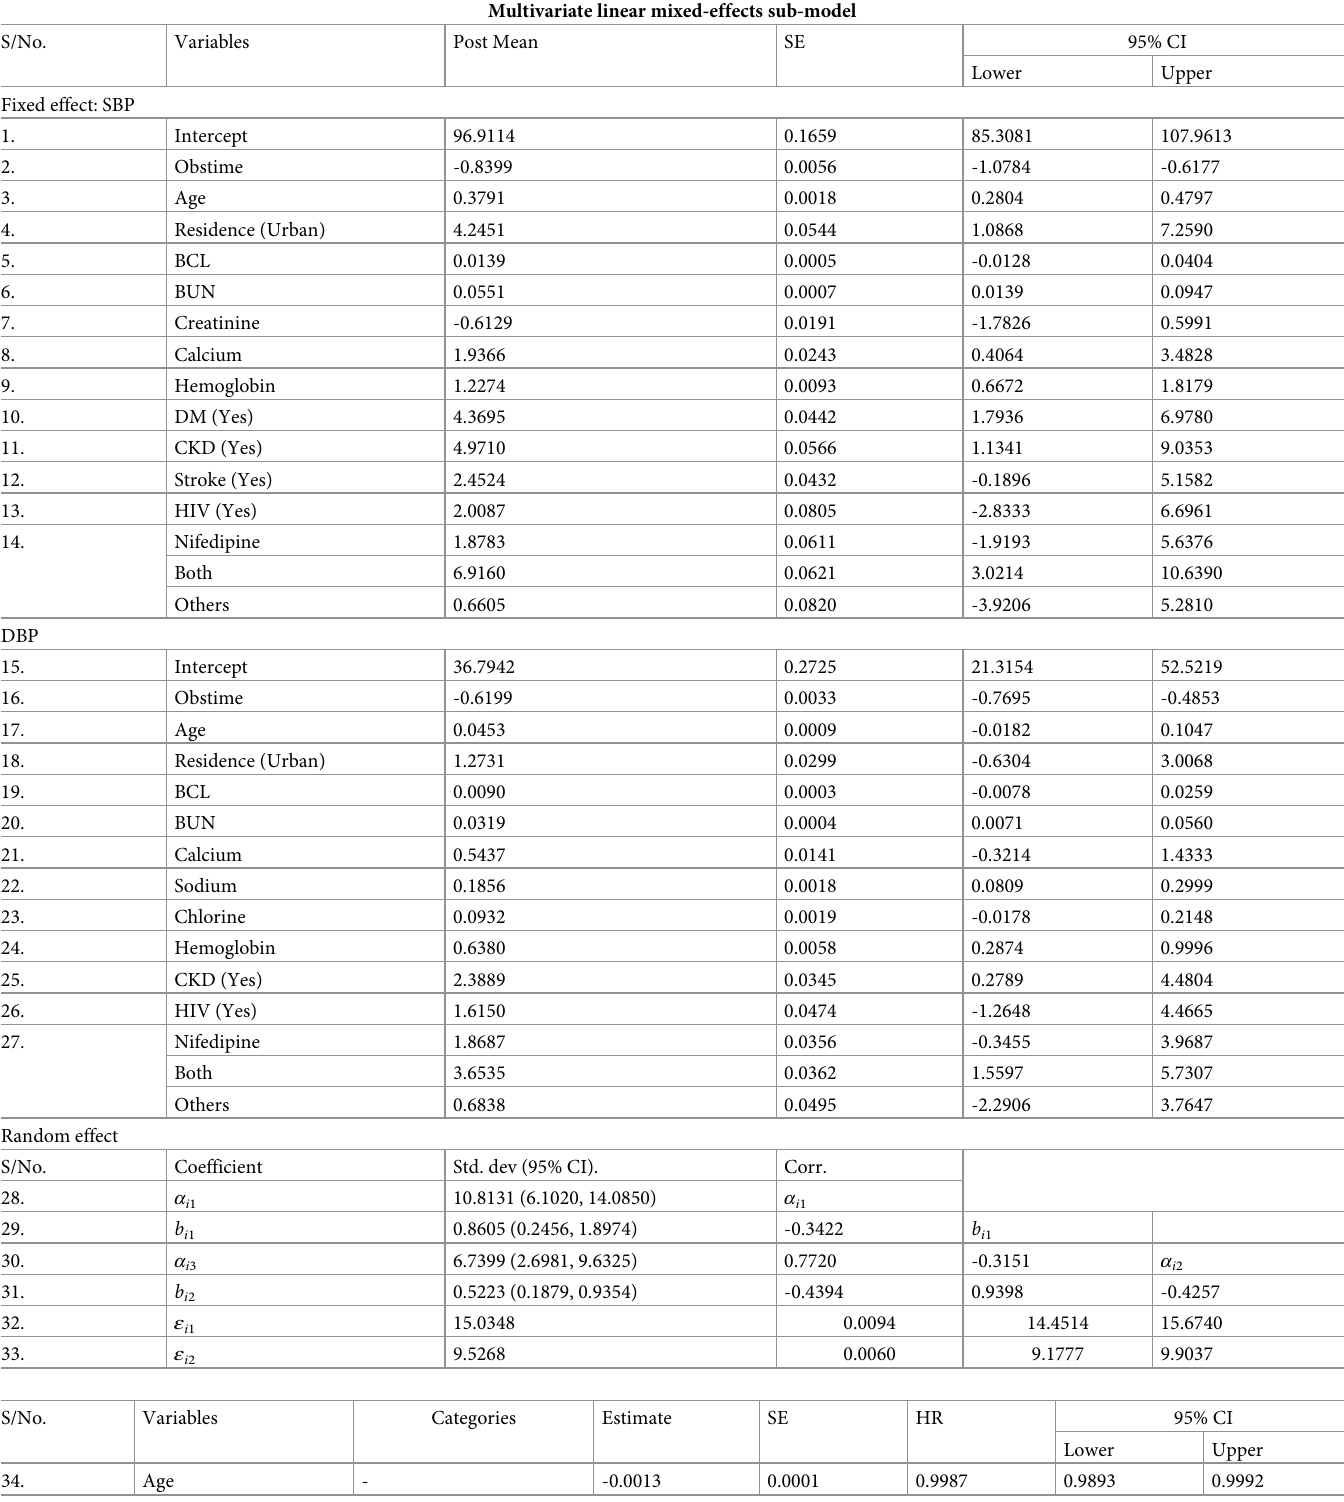
Table 3. Bayesian joint model parameter estimates for longitudinal and survival